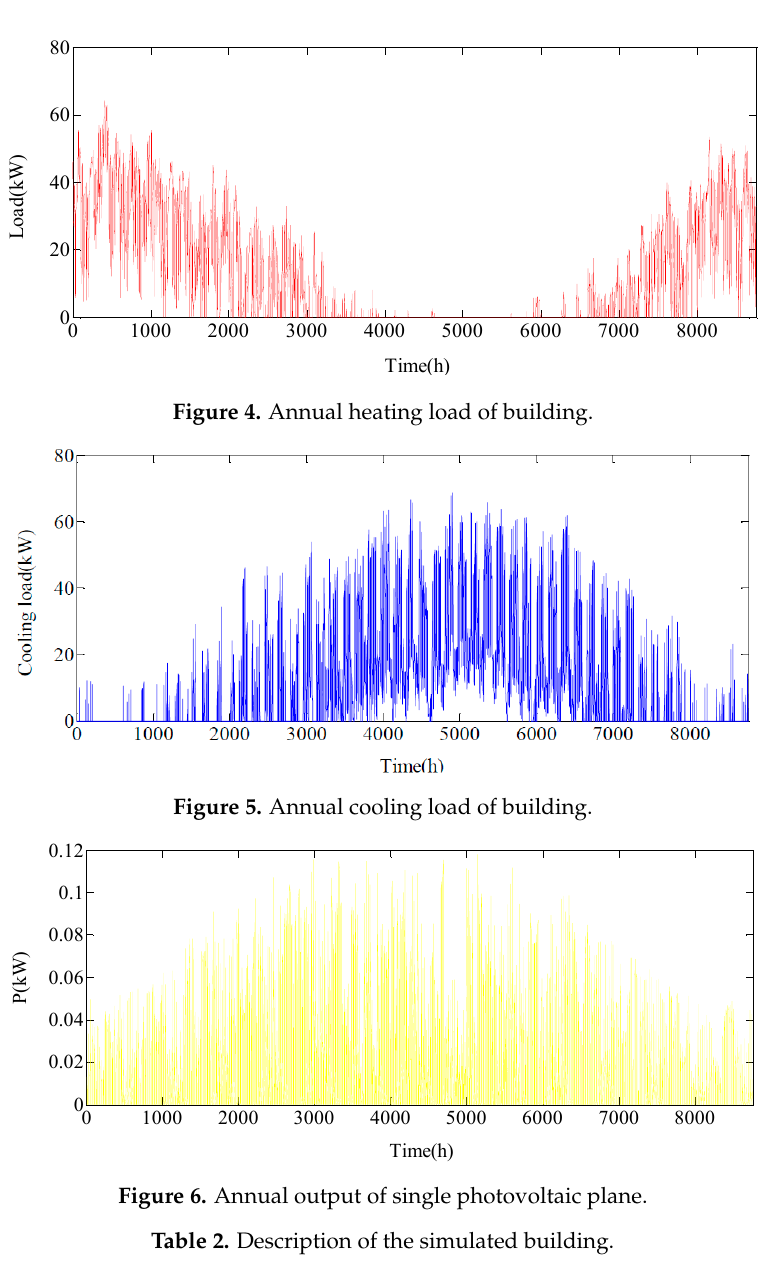
Figure 3. Annual electricity load of building.